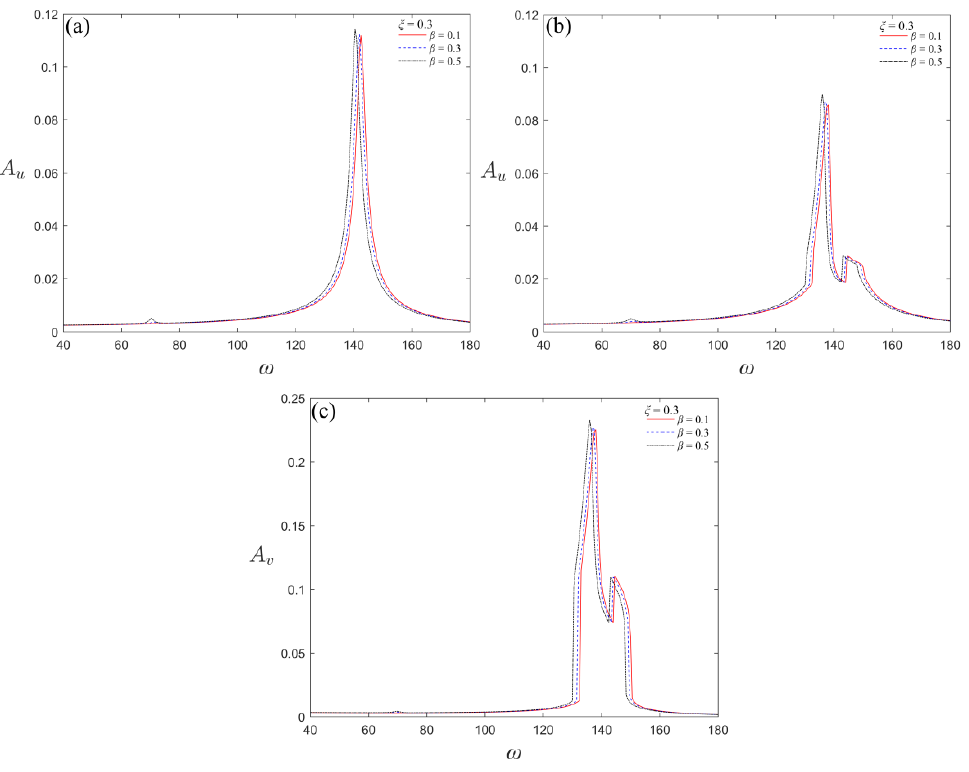
Figure 3. Frequency responses of the beam and NES for different crack parameters: ( a ) beam without NES, ( b ) beam with NES, ( c ) NES.